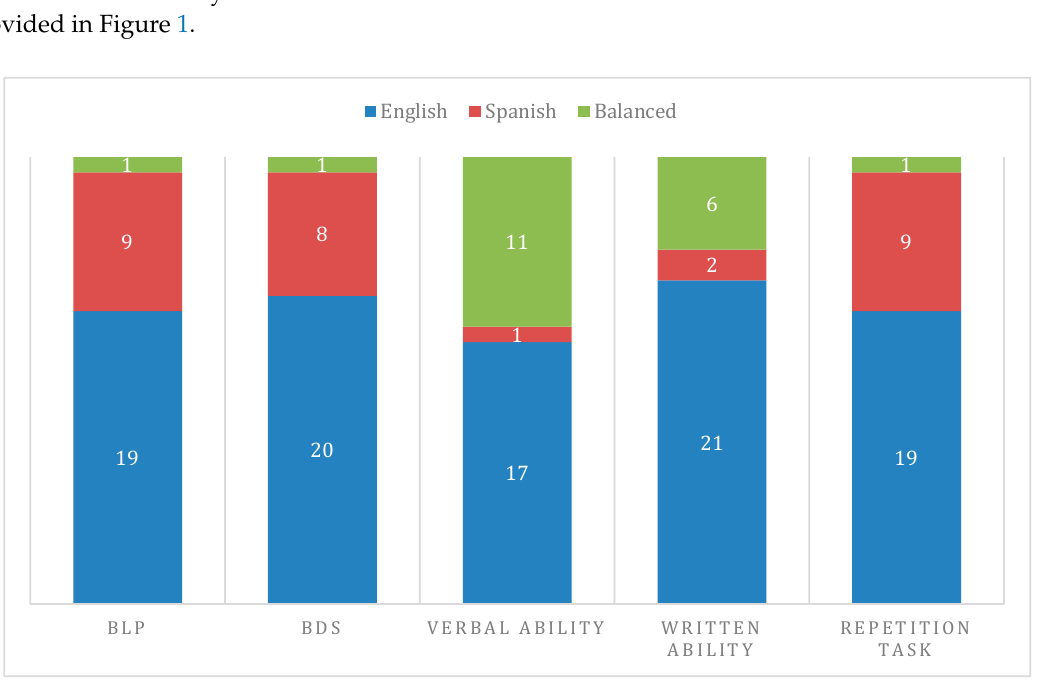
Figure 1. Language dominance classifications.